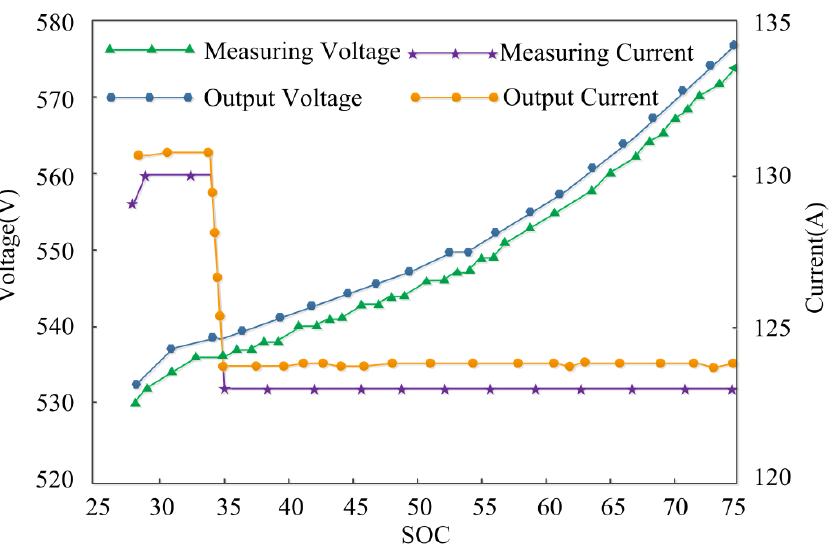
Figure 13. The graph of measuring voltage, output voltage, measuring current, and output current during the charging process of lithium battery EV.